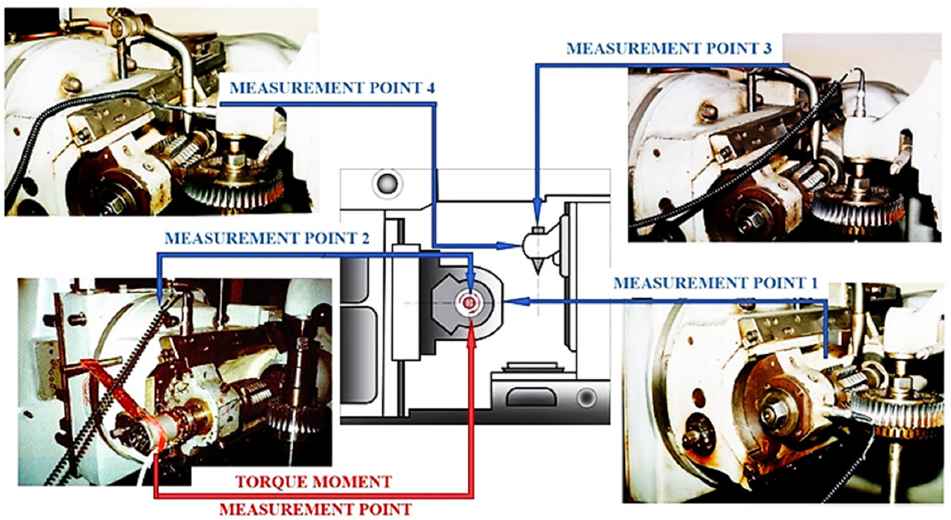
Figure 3. Scheme of measurement points.